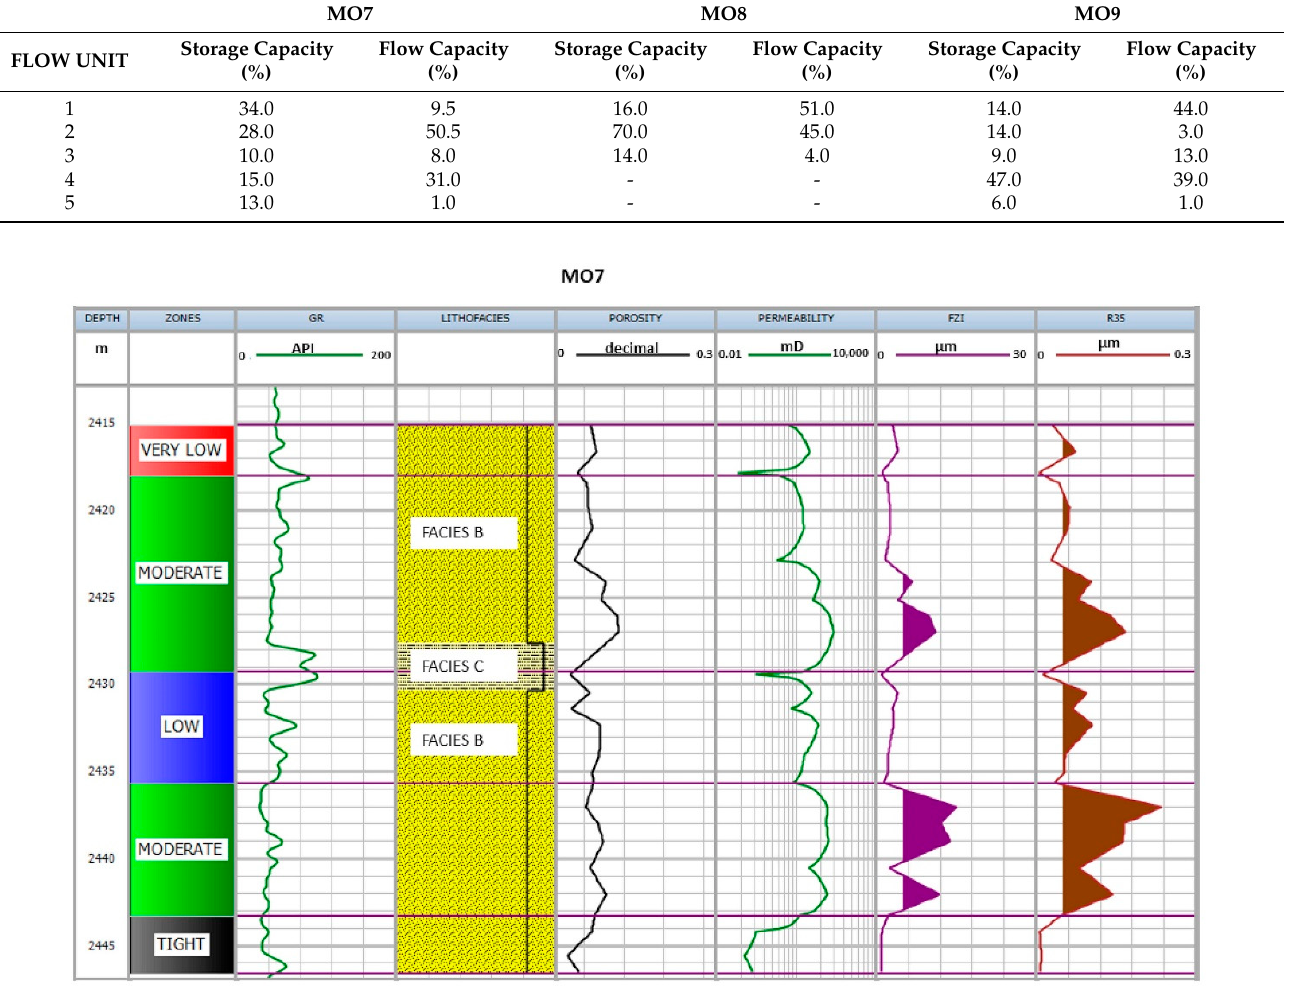
Figure 6. Results of well MO7 showing flow zones in track 2, gamma ray log in track 3, facies in track 4, porosity in track 5, permeability in track 6, FZI in track 7 and r35 in track 8. In comparison, the moderate flow zone below the very low zone contributes 28% and 51% of storage and flow capacities. The combination of the low and moderate flow zones contributes 25% and 39% to storage and flow capacities. The tight flow zone has 13% storage capacity but 1% flow capacity. The upper moderate zone at depth 2418–2429.3 m is the most productive zone with a thickness of 31 m, an average porosity and permeability values of 7.8% and 30